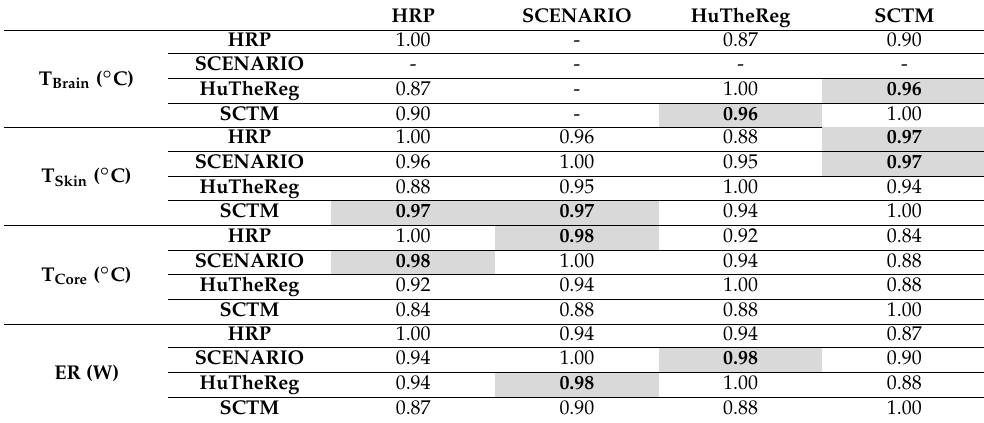
Table 7. Correlation between models predictions for stressful working profile G_14.